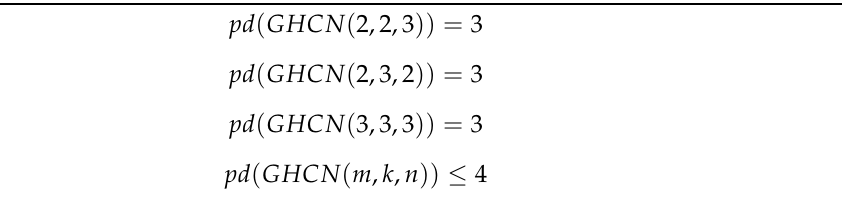
Table 9. Partition dimension of GHCN ( m , k , n )